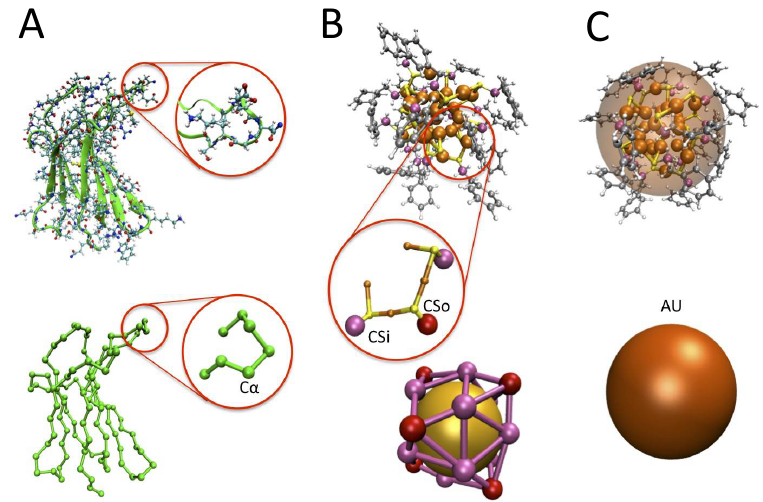
Figure 6. Coarse-graining procedures. ( A ) atomistic and CG-minimalist model of the β 2 µ (the zoomed-in detail reports a loop, with the atomistic detail and the C α beads for the CG case in green) ( B ) atomistic and CG model for the NP. The detail reports the Au (orange) coordinated S atoms (yellow) with the first C atom of the functionalizing chain, colored according to the two possible di ff erent coordinations of their bound S, and named CSo (outer) and CSi (inner), respectively. ( C ) the mesoscale model for the NP, i.e., a single larger